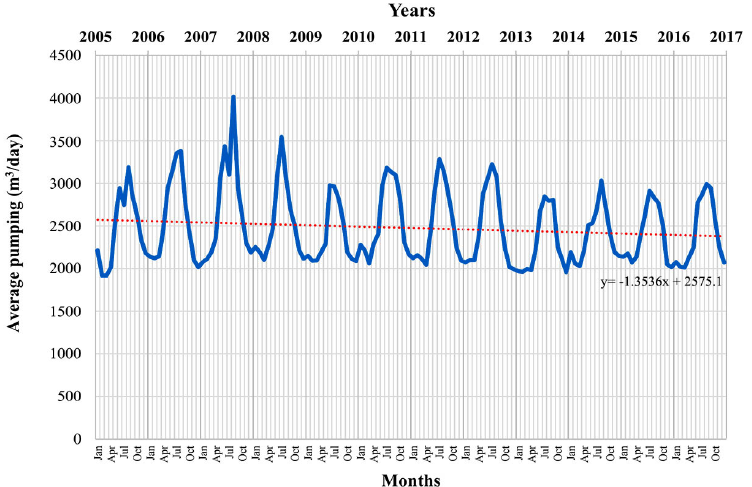
Figure 9. Plot of mean monthly pumped volumes among all the wells screened in the Memphis aquifer during the period 2005 to 2016. Red line shows the decreasing trend in withdrawals as determined by a linear fit.